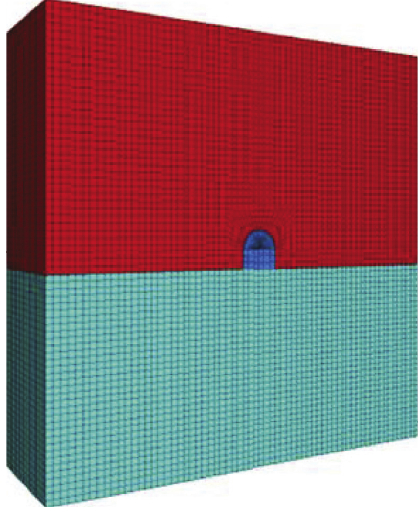
Figure 3: Numerical Table 1: Mechanical parameters of the model.